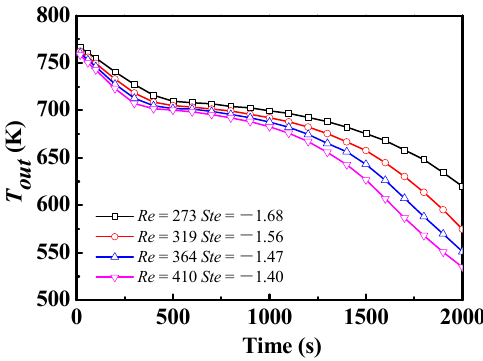
Figure 13. Time evolution of the outlet temperature at different inlet velocity ( Re )/inlet temperature ( Ste ) ( Re / Ste ) numbers under the given inlet power.